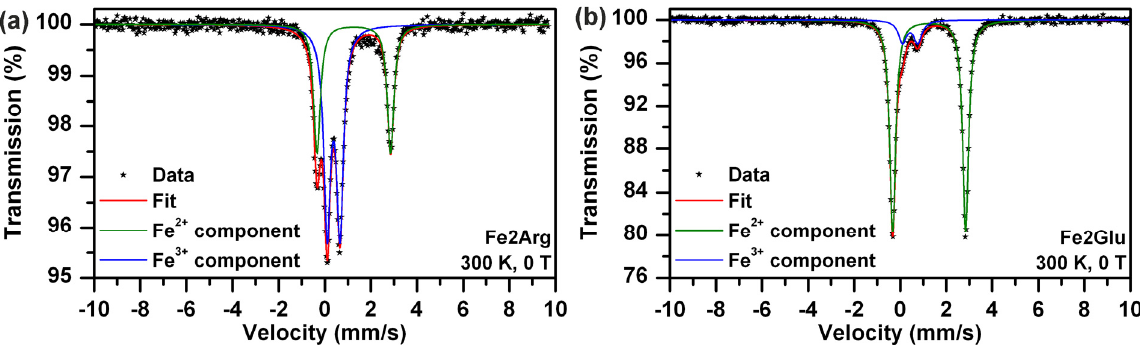
4. ( a ) Mössbauer spectrum of Fe2Arg recorded at room temperature; ( b ) Mössbauer spectrum of Fe2Glu recorded at room